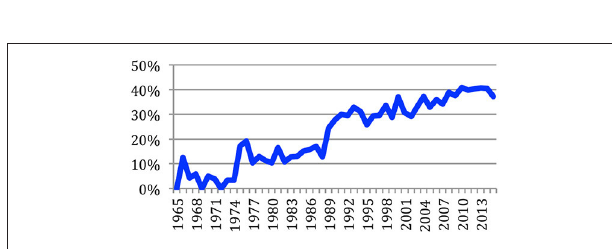
FIGURE 19 | Author redundancy over time.